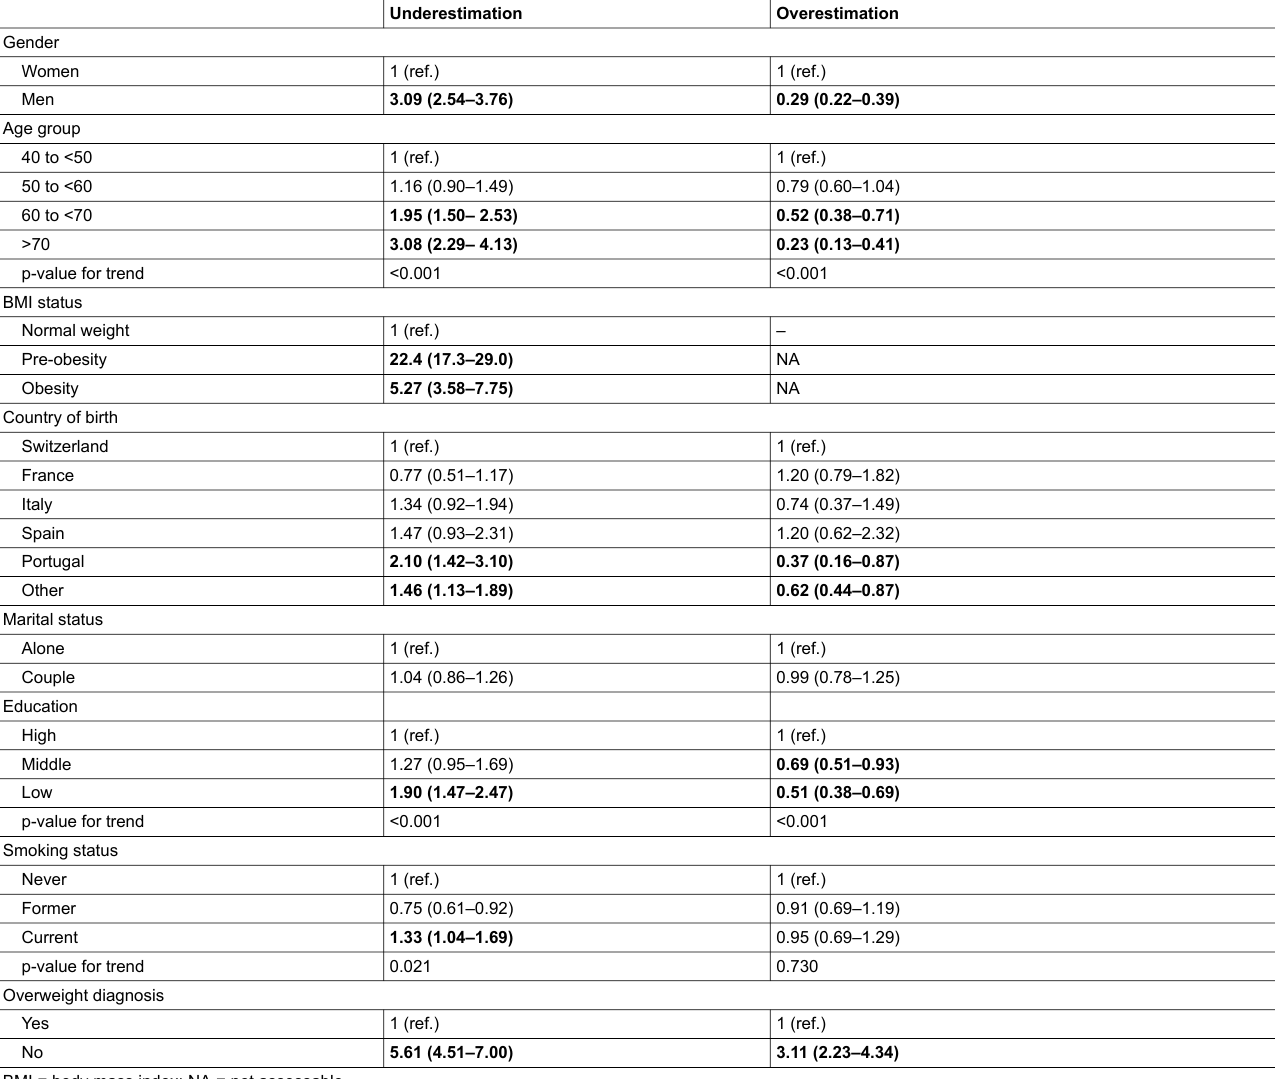
Table 4 : Multivariate analysis of the factors associated with weight under- or overestimation, CoLaus study, Lausanne, Switzerland, 2009–2012.